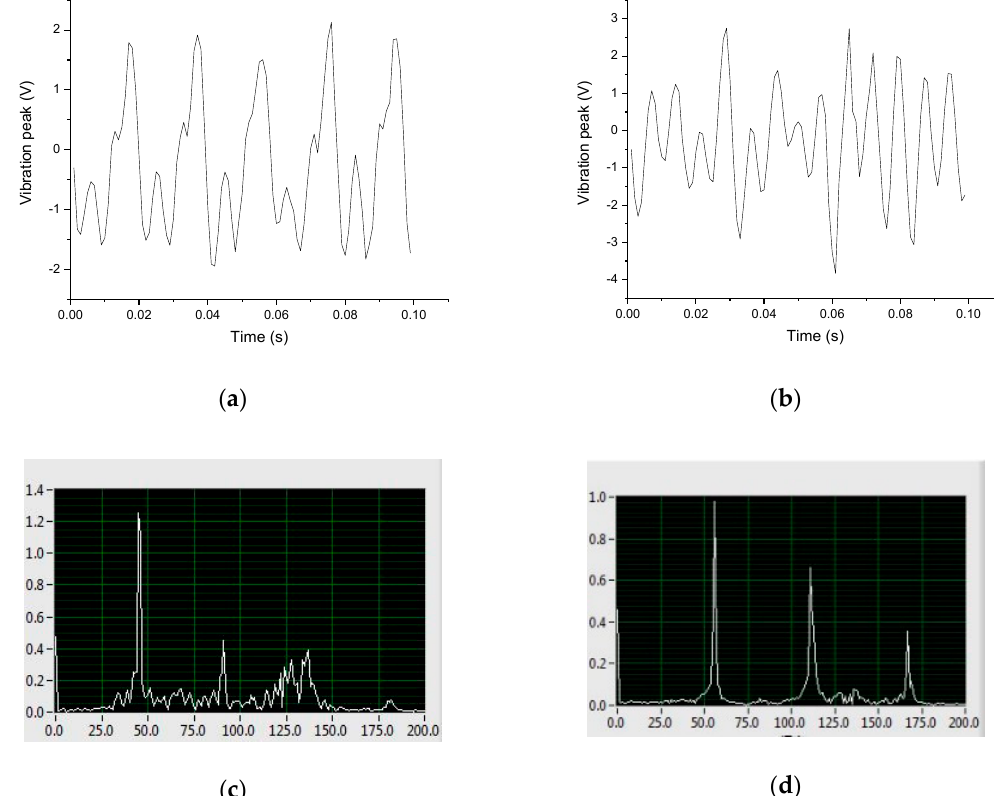
Figure 9. Time-domain and frequency-domain analysis chart of vibration signals. ( a ) Vibration waveform in normal state, ( b ) Vibration waveform of flameout fault, ( c ) Frequency domain diagram of normal state, ( d ) Frequency domain diagram of flameout fault.